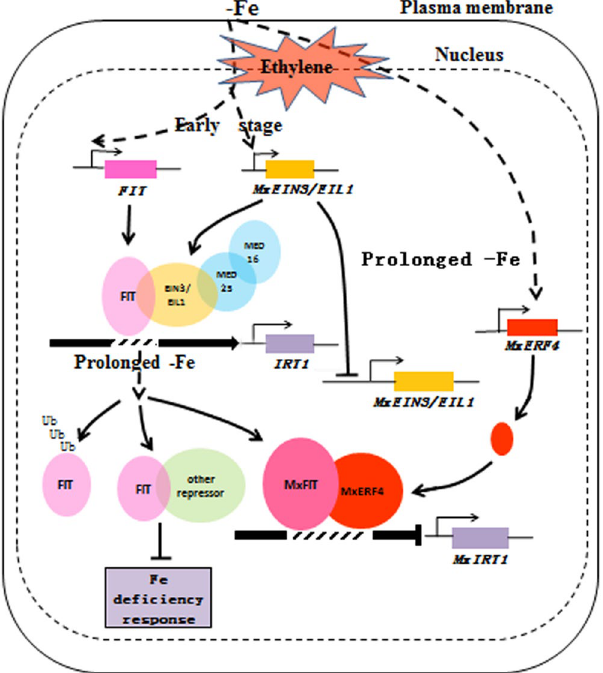
Figure 8. Model of MxERF4 action in suppressing Fe uptake. The early stages of Fe deficiency leads to the induced expression of MxEIN3/EIL1. After prolonged Fe starvation, the expression of MxEIN3/EIL1 is inhibited and the expression of MxERF4 is up-regulated. We propose that MxERF4 can act as a transcriptional repressor through its EAR motif. Ethylene causes an enhanced Fe deficiency adaptive response at the early stages of the response by up-regulating EIN3/EIL1 and the MED complex, but the ethylene response slows down once it has been initiated via the action of MxERF4. MxERF4 eventually interact with MxFIT and suppresses MxIRT1 gene